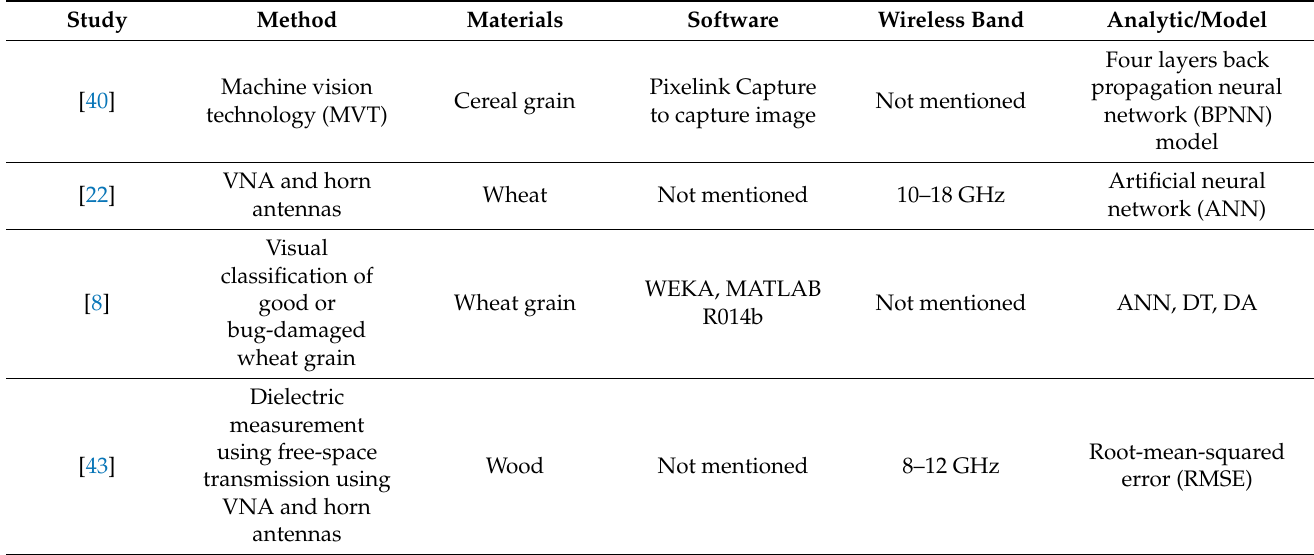
Table 2. Related